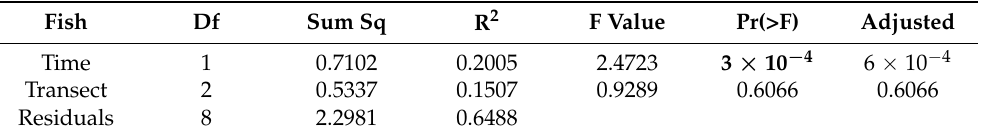
Table 4. PERMANOVA (permutational multivariate analysis of variance) with a 4th root transfor- mation testing for a difference in the biodiversity of fish at Coral Greenhouse across time. A million permutations were used with the transect as a blocking factor. p -values were adjusted to account for repeated cases using the Benjamini and Hochberg method (1995). Significant values in bold .